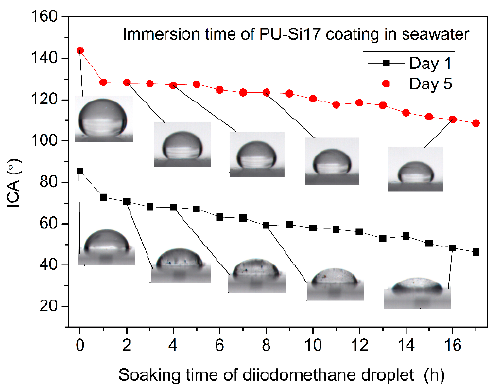
Figure 15. Long time interface contact angles (ICA) in-situ measurements of diiodomethane for PU-Si17 sample immersed in seawater. Coatings 2018 , 8 , x FOR PEER REVIEW